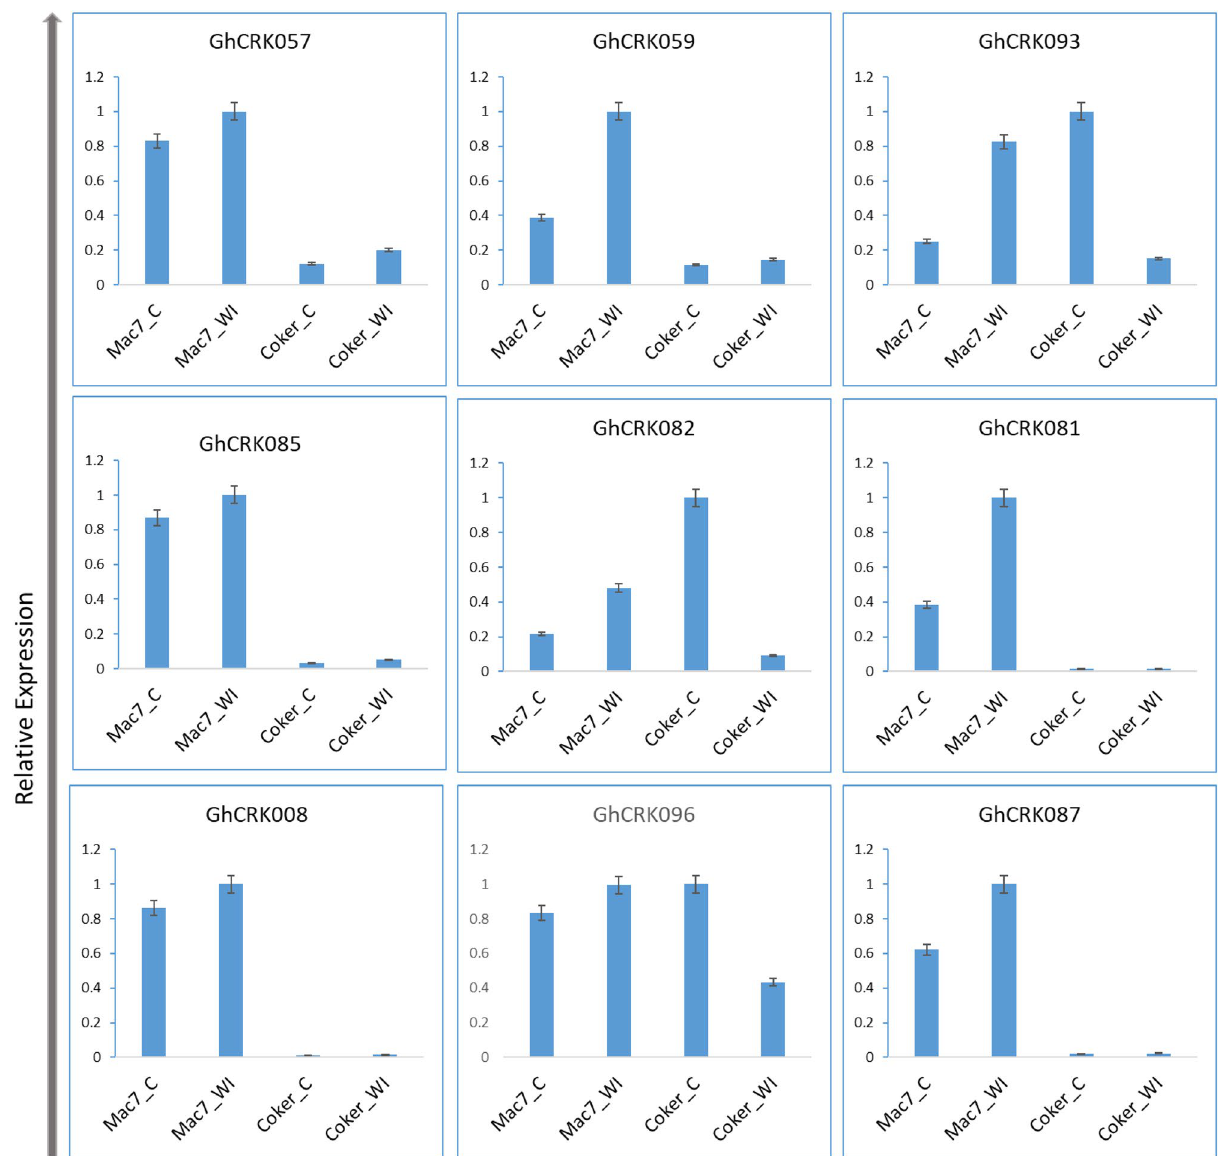
Figure 8. Relative expressions of GhCRKs under cotton leaf curl disease. Mac7_C; resistant control, Mac7_WI; resistant infested with viruliferous whitefly, Coker 312_C; susceptible control, Coker 312_WI; susceptible infested with viruliferous whitefly. Error bars represent the SD of three independent